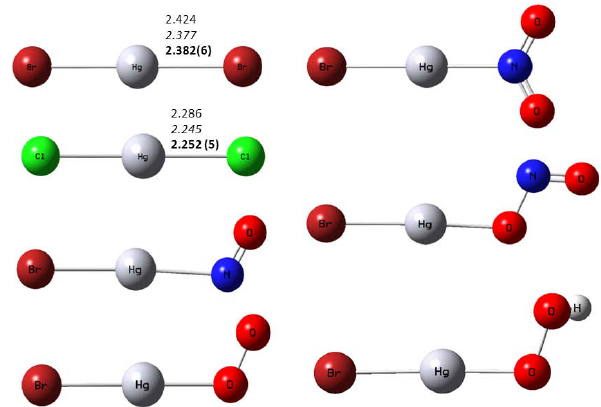
Fig. 1. Structures of various BrHgY molecules and HgCl 2 with BrHg-Y bond lengths in ˚Angstroms. For HgBr 2 and HgCl 2 we also report bond lengths calculated by Balabanov and Peterson (2003a, in italics) and values from experiment (Deyanov et al., 1985 and Kashiwabara et al., 1973) in bold. Numbers in parentheses are 2 s.d. of the experimental bond